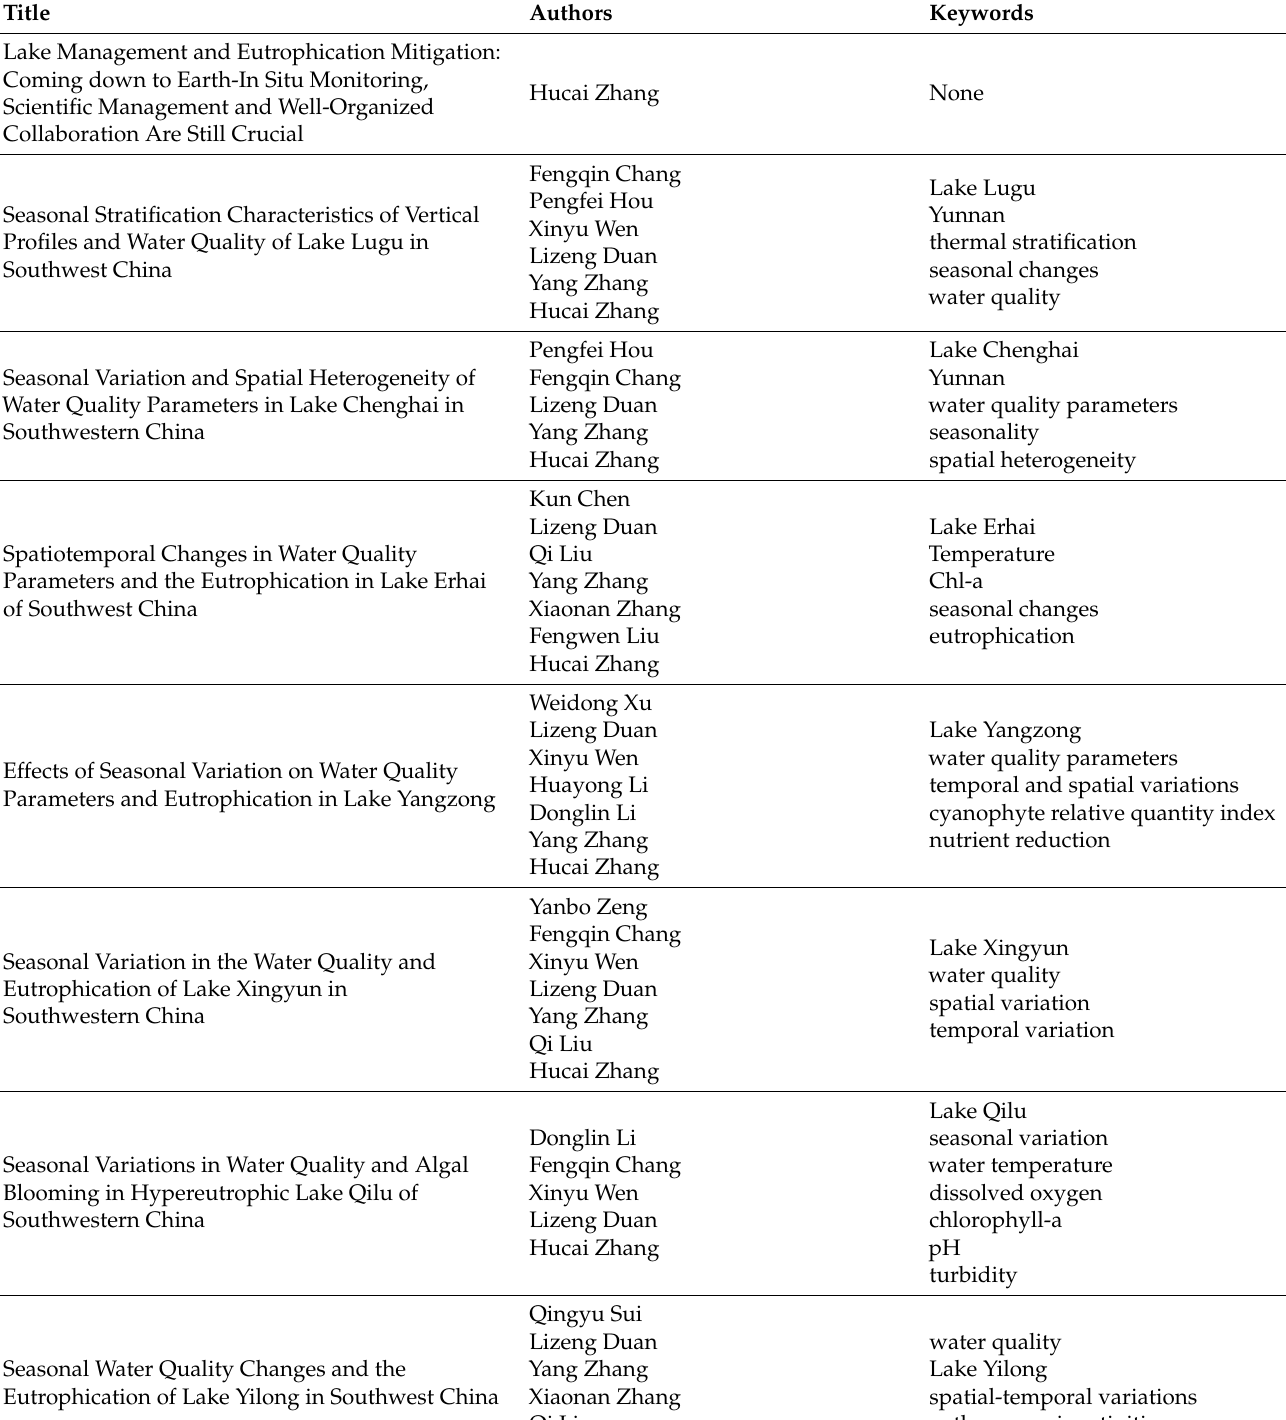
Table 1. Summary of the papers published in the Special Issue entitled “Plateau Lake Water Quality and Eutrophication: Status and Challenges” for the journal Water